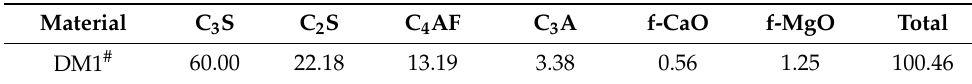
Table 1. The chemical composition of cement clinker (wt/%).